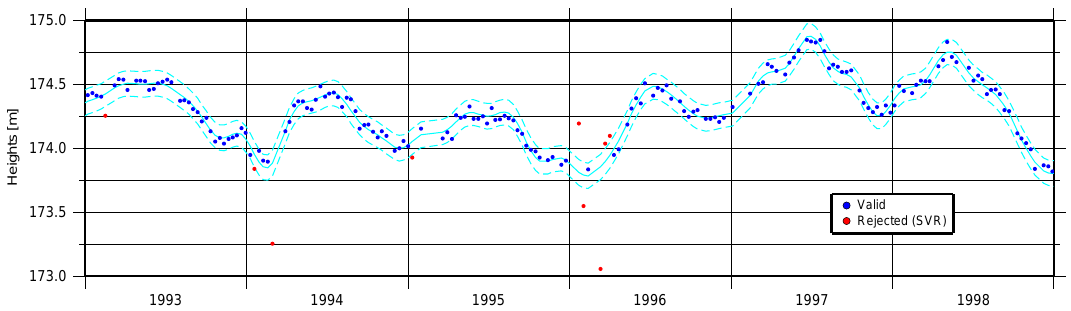
Figure 4. Example of applied SVR using radial base functions for outlier rejection on a resulting water level time series (Lake Erie) of the Kalman filtering step. The estimated regression function (cyan) and its confidence intervals (dotted cyan) are plotted. The result of the regression shows valid (blue) and rejected (red) altimeter heights. Each rejected water level height represents one complete satellite overflight.